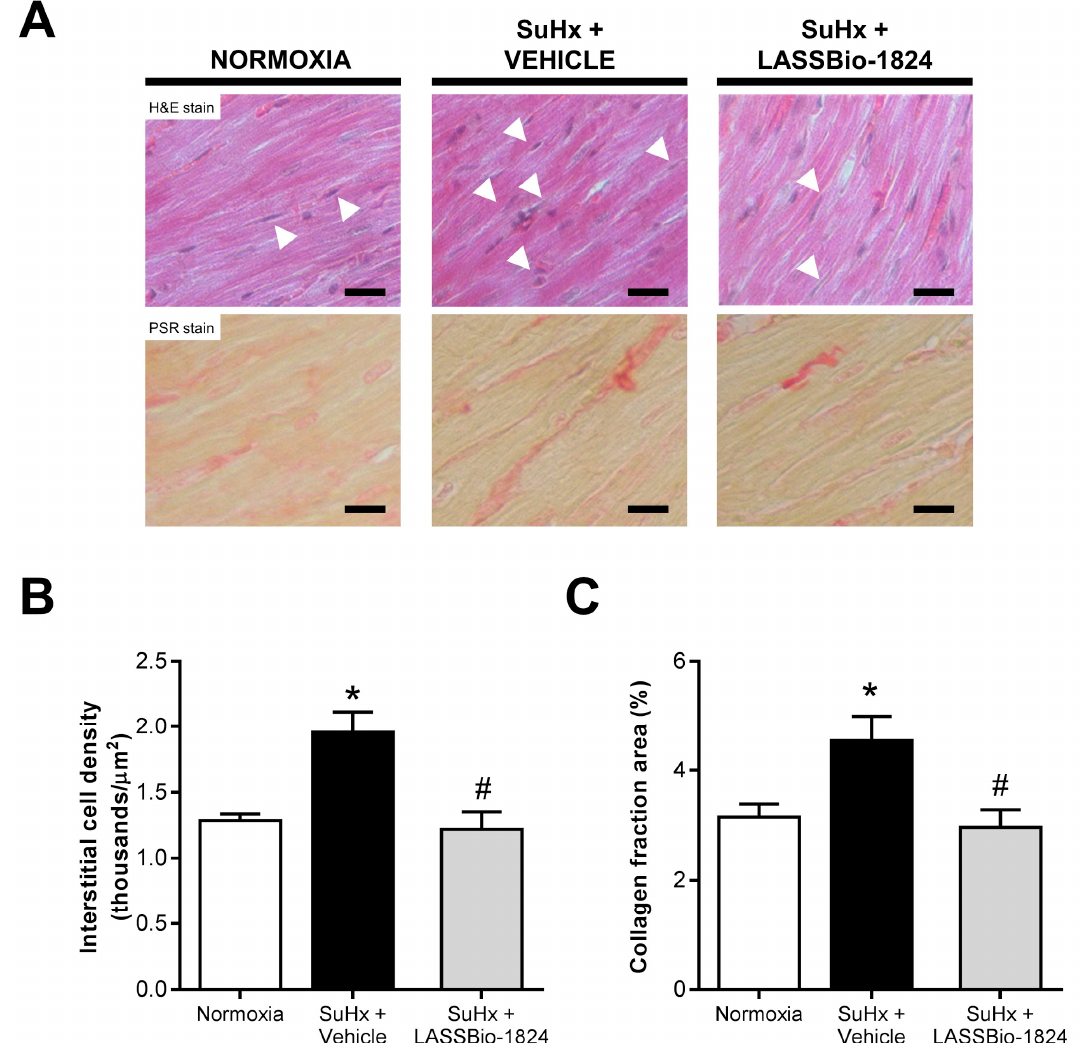
Figure 4. Impact of LASSBio-1824 on RV histology in SuHx. ( A ) Representative micrographs of RV sections with H&E and PSR stains. White arrowheads indicate interstitial cell nuclei. Bars represent 20 µ m. ( B ) Interstitial cell density in RV tissue ( n = 5 rats per group). ( C ) Red-stained collagen area of RV ( n = 5 rats per group). H&E, hematoxylin-eosin; PSR, picro-Sirius red; RV, right ventricle. * p < 0.05 compared to normoxia. # p < 0.05 compared to SuHx + Vehicle.